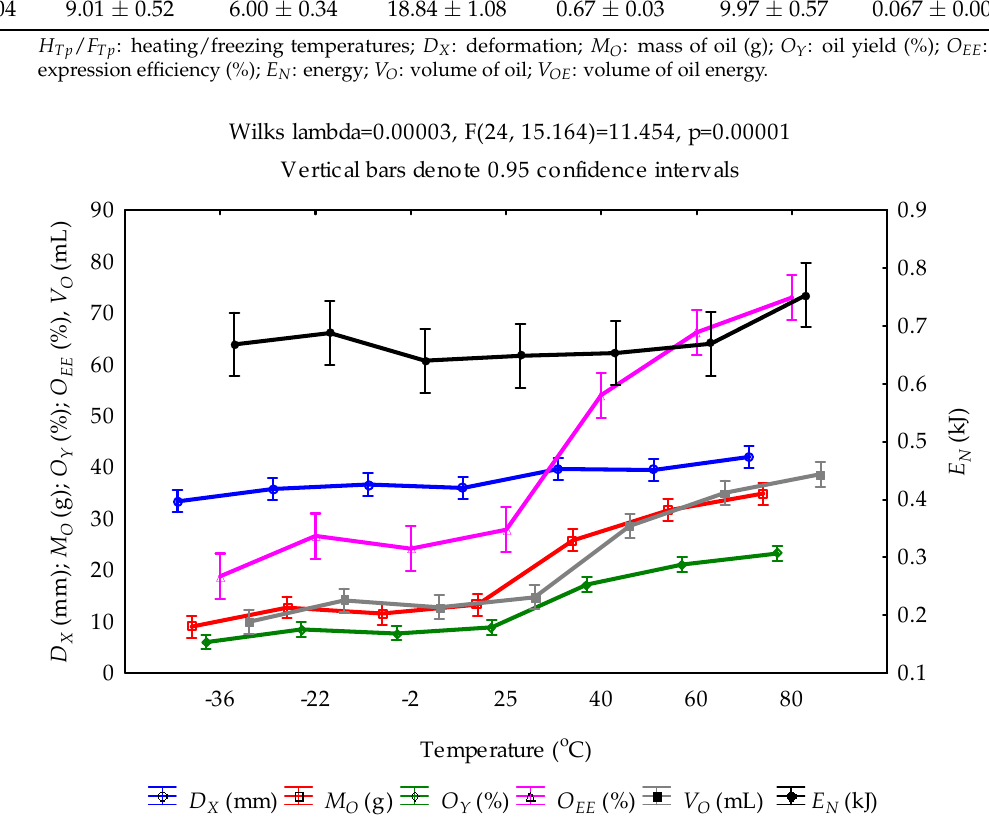
: deformation; & : mass of oil; ( : oil % ’ ) : energy and - : volume of oil) grouped by temperature , ’